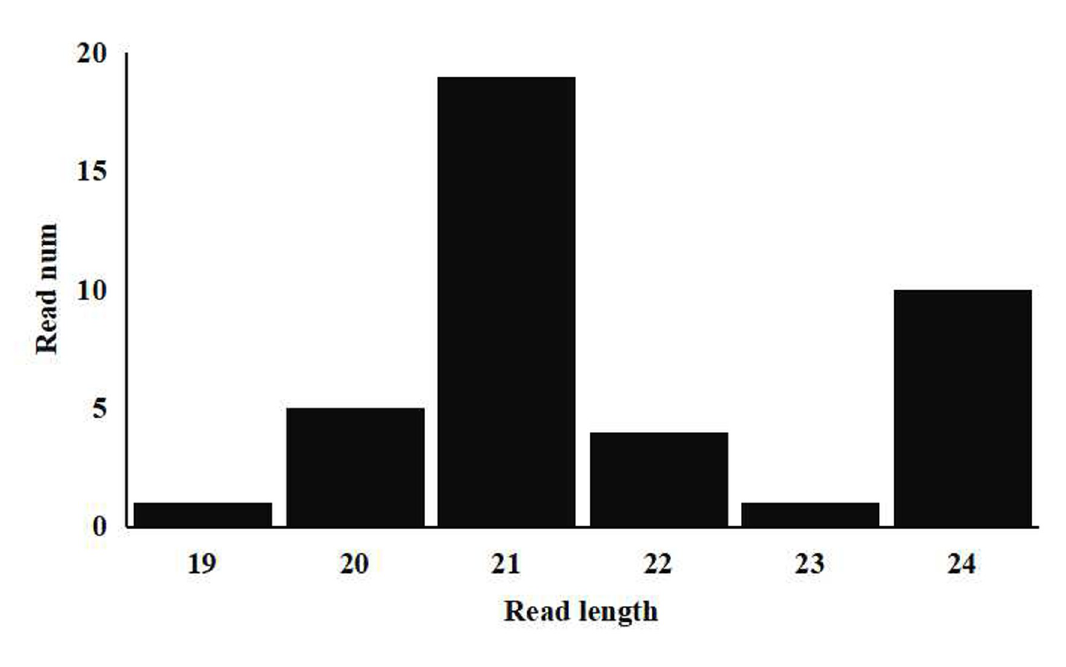
Fig 4. Conserved miRNA mature length